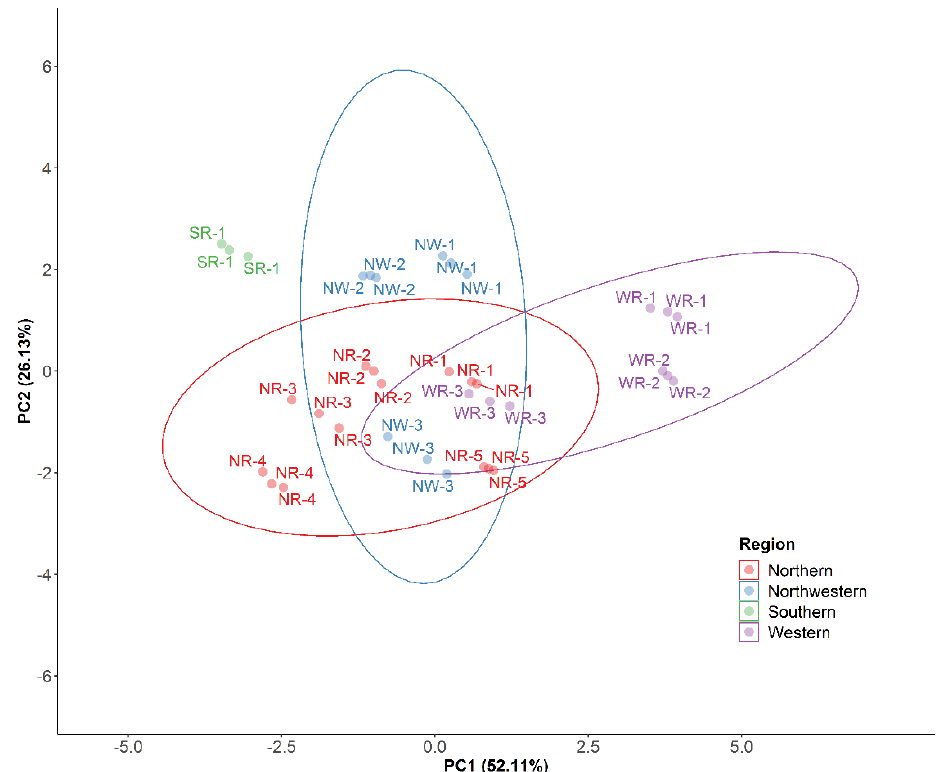
Figure 14. Plane defined by two first principal components (PC1 and PC2) resulting from the PCA analysis of Z. officinale rhizomes ( n = 12) contents. Regions: Northern (NR), Northwestern (NW), Southern (SR), Western (WR).